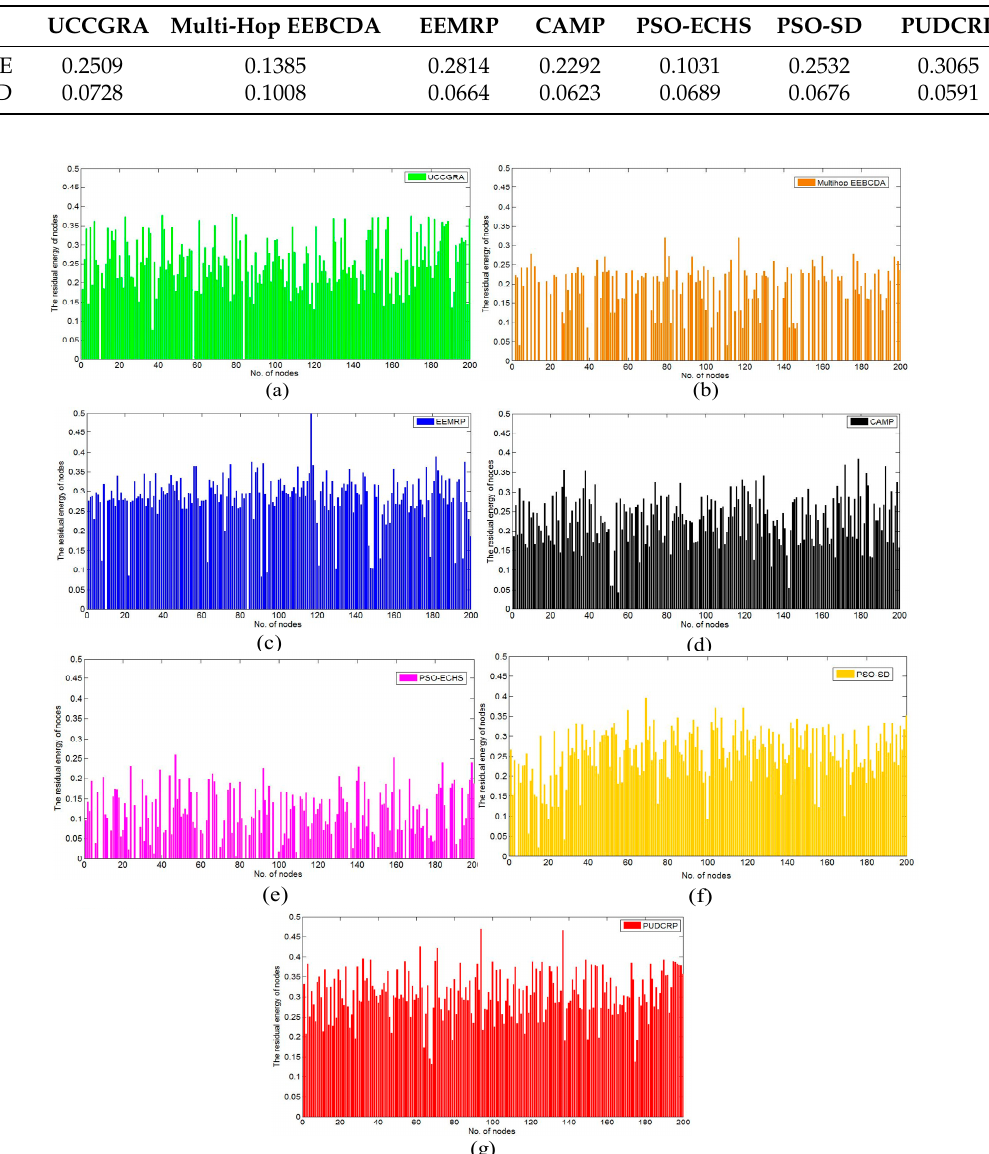
Figure 15. Residual energy of nodes under different algorithms in the 500th round: ( a ) UCCGRA; ( b ) Multihop EEBCDA; ( c ) EEMRP; ( d ) CAMP; ( e ) PSO-ECHS; ( f ) PSO-SD; ( g ) PUDCRP.